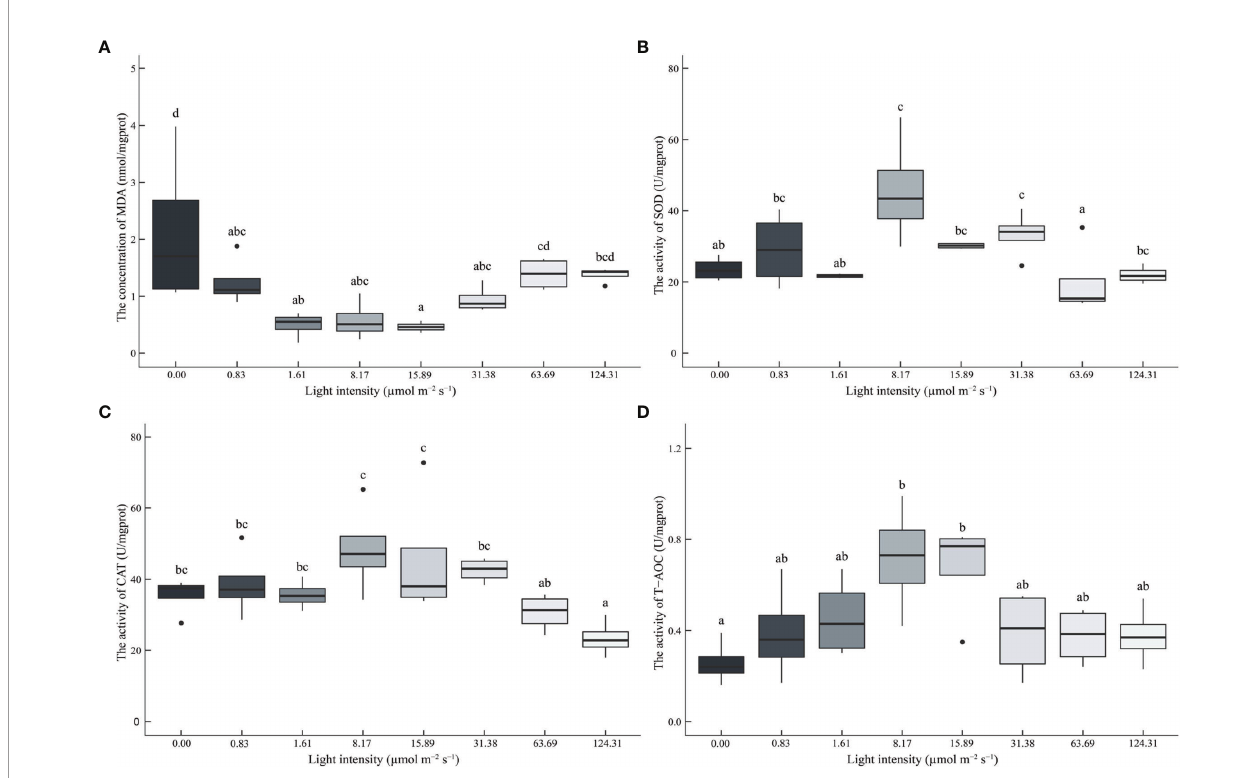
FIGURE 5 | Effect of different light intensities on the malondialdehyde (MDA) (A) contents, superoxide dismutase (SOD) (B) , catalase (CAT) (C) , and total antioxidant capacity (T-AOC) (D) in the hepatopancreas of juvenile Portunus trituberculatus . Data (n=4) with different letters signi fi cantly differ ( P < 0.05) among